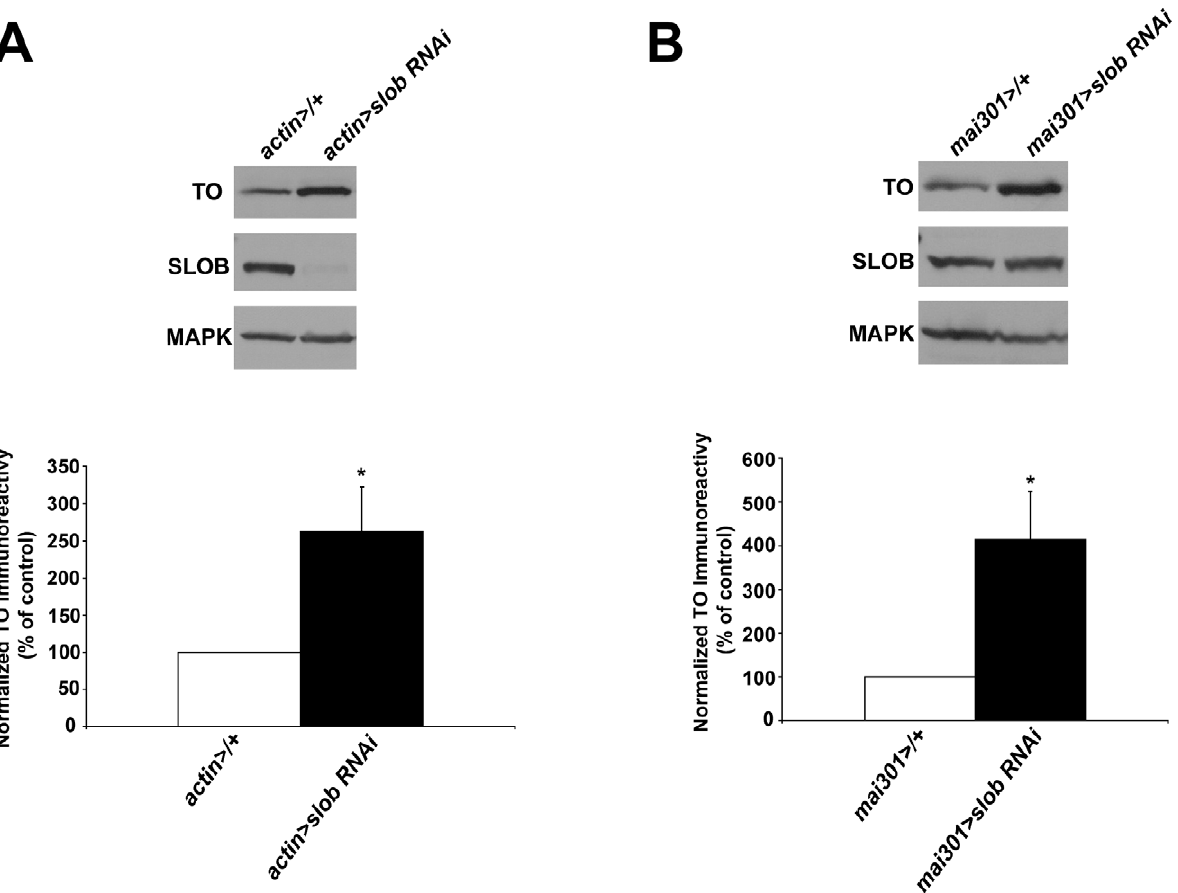
Figure 4. TO protein levels are dependent on expression of SLOB. TO protein levels in fly heads were measured by Western blot analysis and normalized to MAPK levels. A , Representative Western blot showing increased TO in heads of flies in which SLOB expression was knocked down ubiquitously using RNAi. The graph is a summary of five independent experiments (mean 6 SEM). B , Representative Western blot showing increased TO in heads of flies in which SLOB expression was knocked down in mNSCs using RNAi. The graph is a summary of six independent experiments (mean 6 SEM). * indicates p , 0.05, One-way ANOVA with Bonferroni post-test.